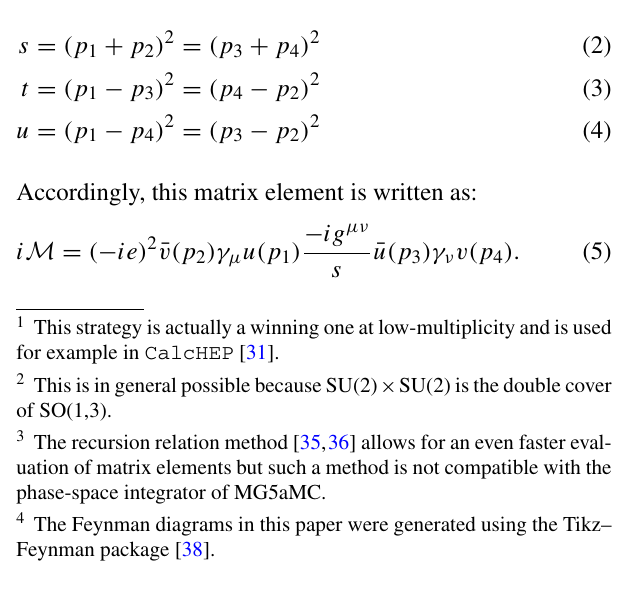
used by programs that perform numerical evaluations of matrix elements. This is because such a formalism will cause the computational complexity to grow quadratically with the number of Feynman diagrams (due to the presence of inter- ference terms).